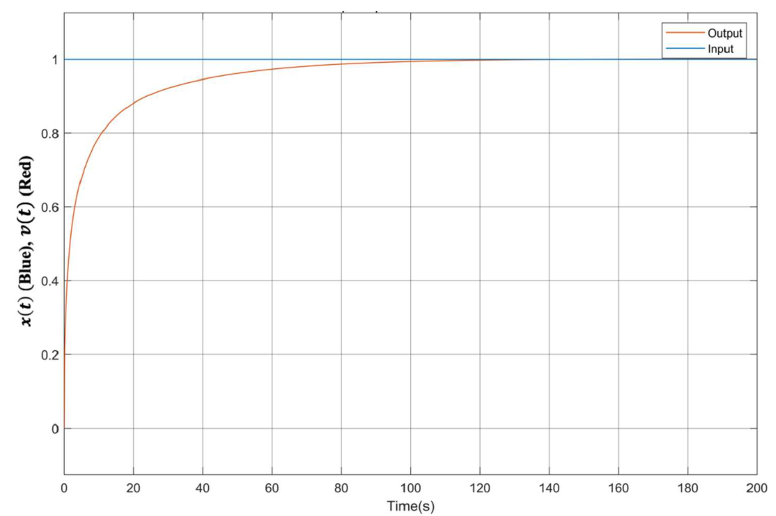
Figure 9. Response to Step Input with Technique 4.